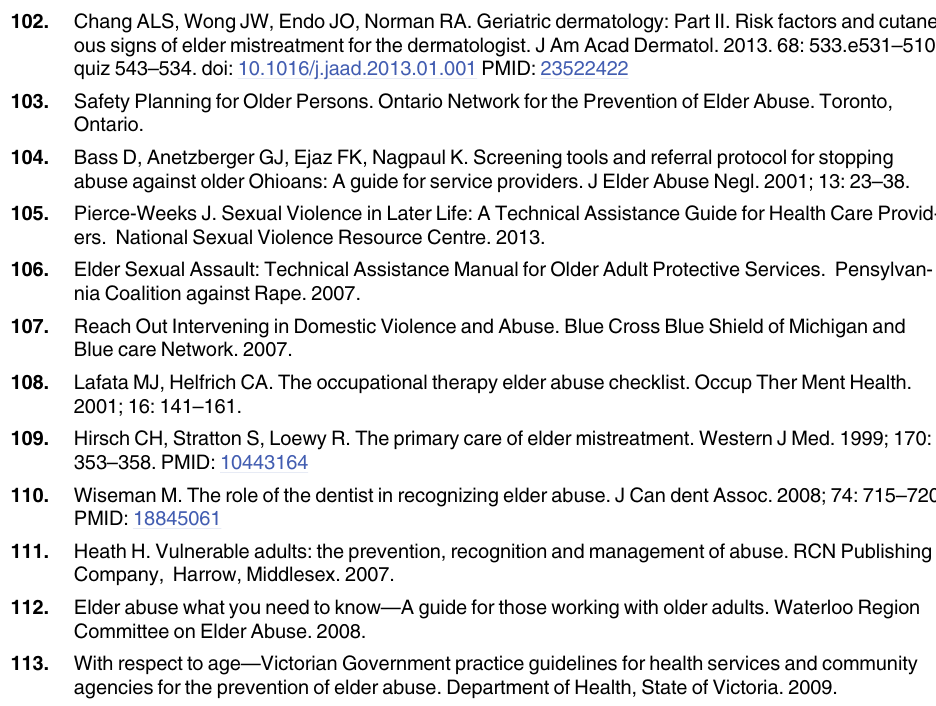
PLOS ONE | DOI:10.1371/journal.pone.0125105 May 4,